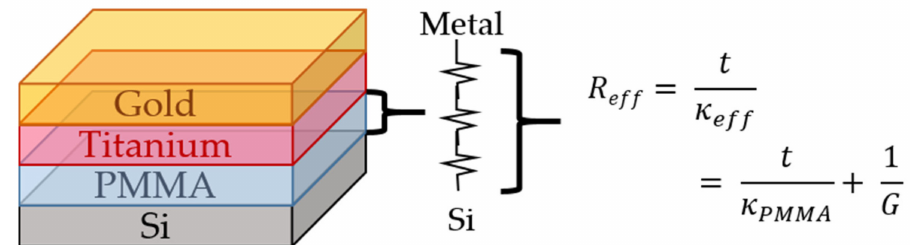
Figure 3. Schematic of a typical sample. The thermal resistance circuit gives a total thermal resistance R eff of the PMMA layer, which is a sum of the interfacial ( G 1,2 ) and bulk ( κ PMMA ) contributions. The Si substrate has a native oxide layer which has been omitted in the figure for